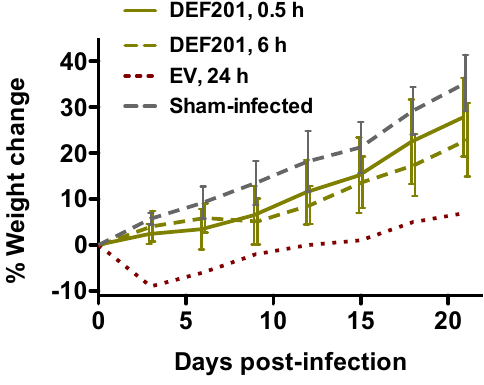
Figure 5. Surviving hamsters recover from initial weight loss due to DEF201